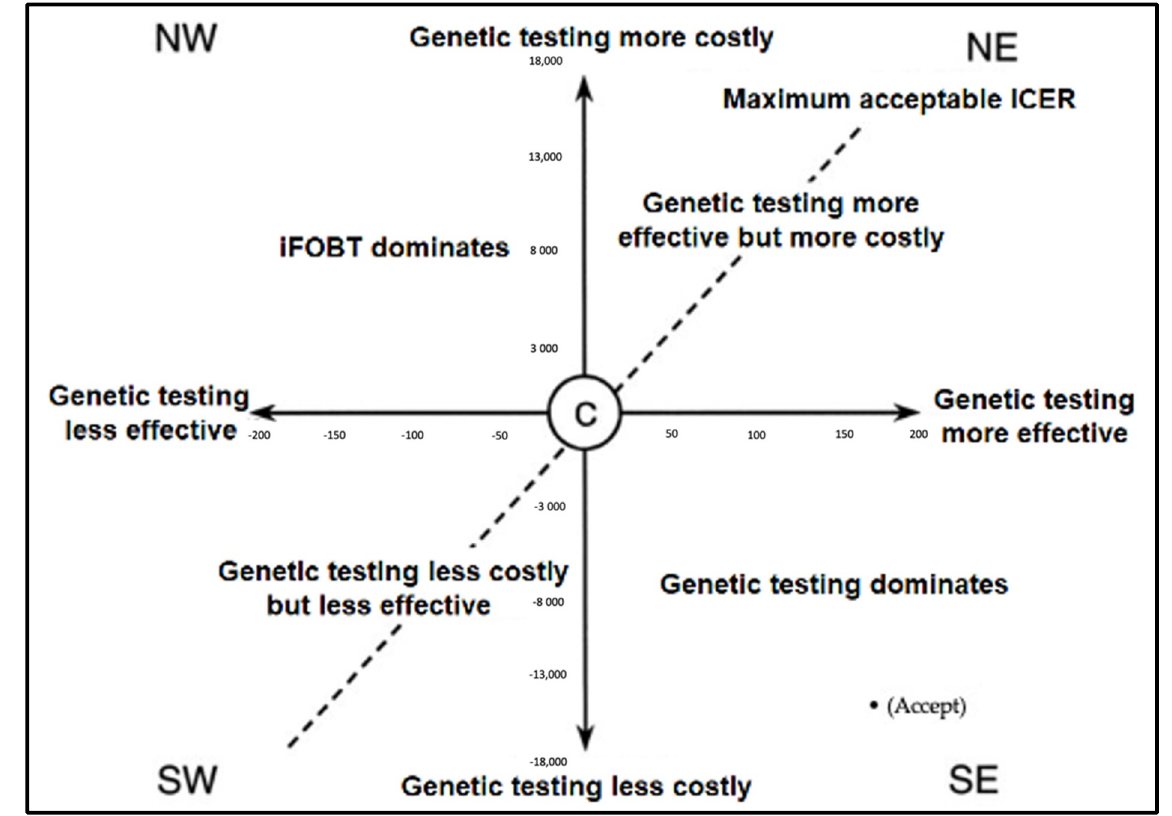
Figure 1. The cost-effectiveness plane and decision rules for CRC genetic testing compared to iFOBT. iFOBT: immunological-based fecal occult blood test; ICER: incremental cost-effectiveness ratio